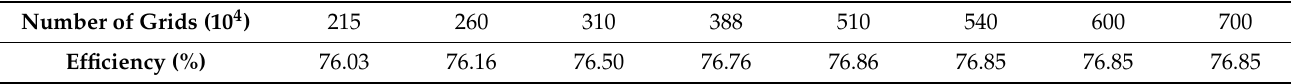
Table 1. Effect of grid number on pump device